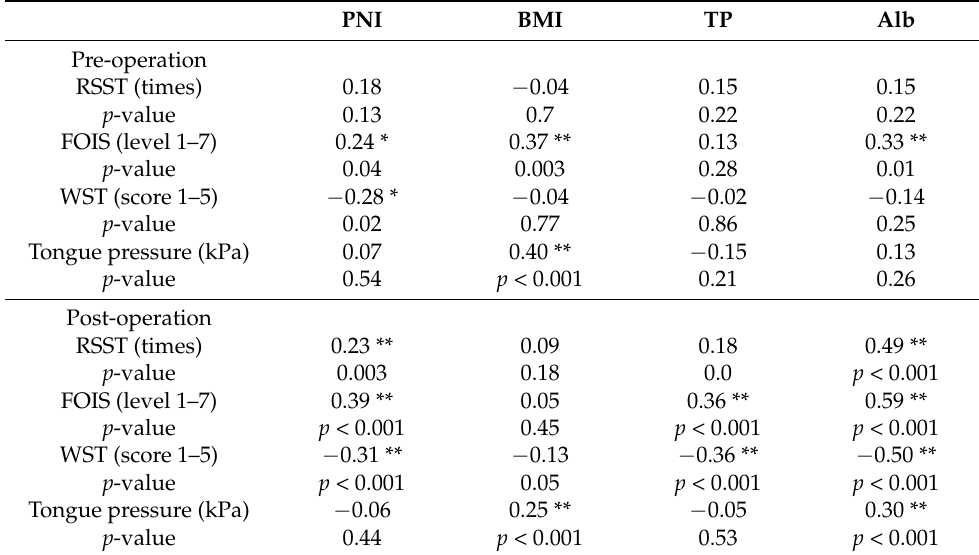
Table 4. Correlation between nutritional status and